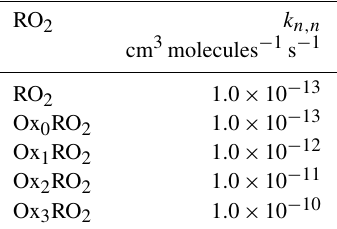
Table 1. Self-reaction rate constants for RO 2 and Ox n RO 2 are shown. As peroxy radicals become more oxidized, the assumption is that their association rate constants